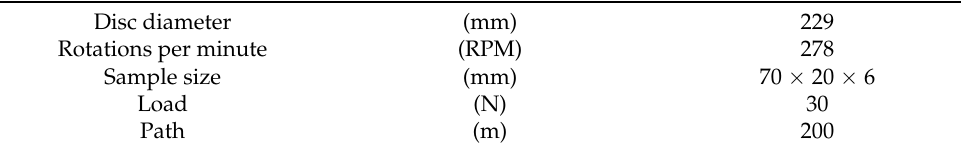
Table 2. ASTM G65-16 parameter settings during the testing process.